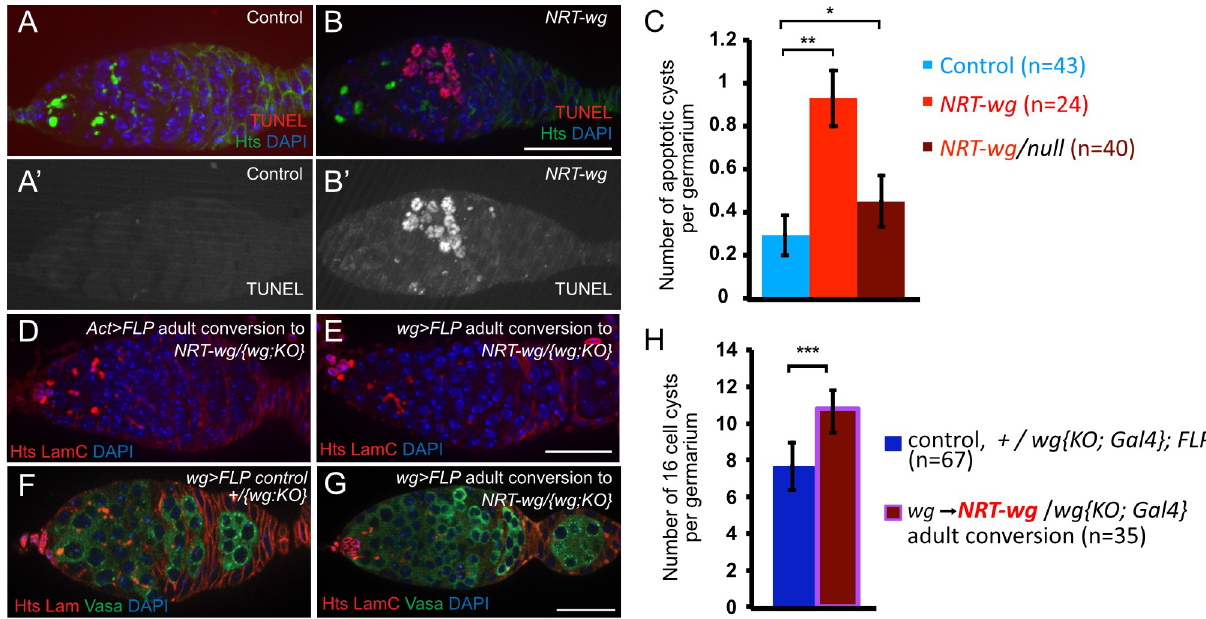
Fig 4. Germaria with tethered Wingless had too many germline cysts. A-C. Apoptotic cysts were detected in germaria by TUNEL. Controls expressing wild-type wg (A) showed few apoptotic cysts, whereas germaria from flies expressing only NRT-wg throughout development had substantially more apoptotic germline cysts (B), on average about 1 apoptotic cyst per germarium (C). Bar: 25 μ m. D-E. The wg locus was converted to express NRT- wg during adulthood by either Act > FLP (D) or wg > FLP (E) under Gal80 ts control. Egg encapsulation proceeded normally in nearly all germaria, 35/40 germaria for Act > FLP and 31/32 for wg > FLP . Bar: 25 μ m. F-H. When the wg locus is converted to NRT-wg during adulthood by wg > FLP , germaria contain increased numbers of germline cysts (G) compared to controls in which no conversion occurred (F). Germline cysts are evident with anti-Vasa staining (green). Bar: 25 μ m. Error bars are standard deviation.